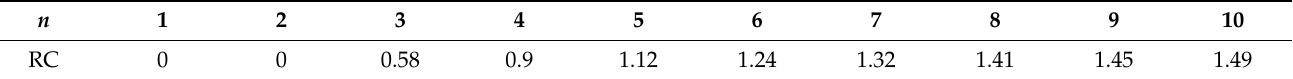
Table 6. Random consistency (RC) index (n = size of the reciprocal